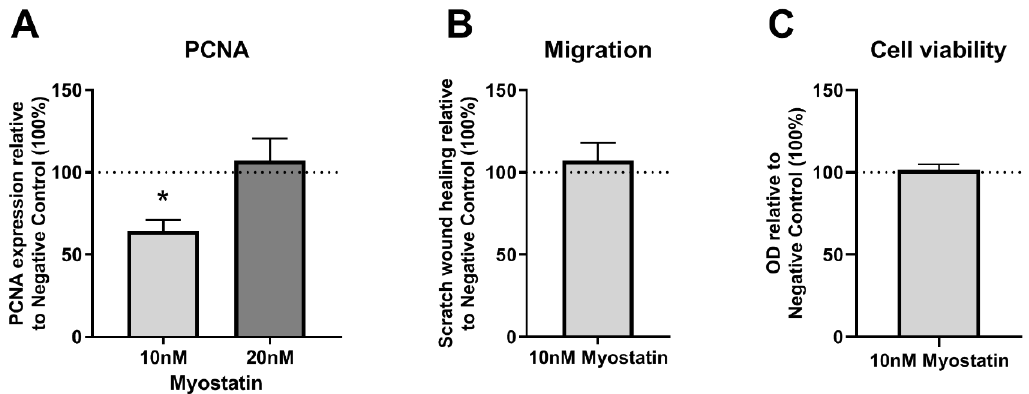
Figure 3. ( A – C ): PCNA expression, cell migration and cell viability in myostatin treated VSMCs relative to non-myostatin treated control (100%). ( A )—PCNA mRNA expression in myostatin treated VSMCs was downregulated at 10 nM myostatin, but not at 20 nM myostatin, n = 3. ( B )—Scratch wound healing in myostatin treated VSMCs was not changed, n = 3. ( C )—Cell viability in myostatin treated VSMCs remained unchanged, n = 4. Mean expression is shown and error bars represent SEMs. One-sample t-test performed with 100% of Negative Control expression as control group.